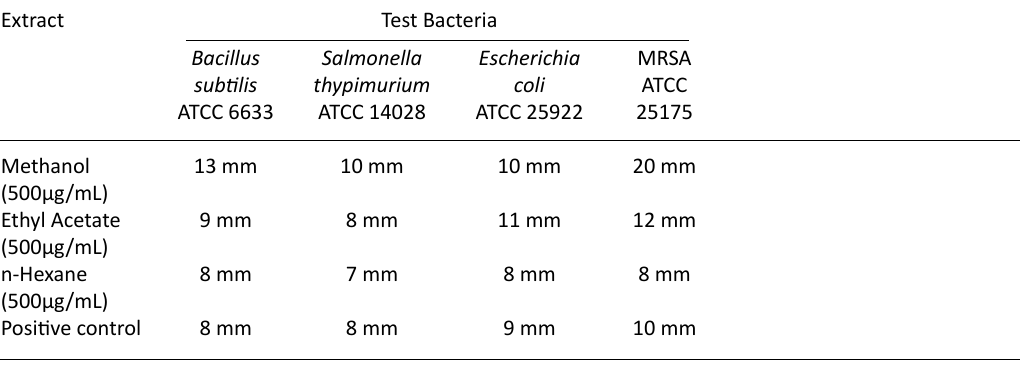
Table 4. Results of Measurement of Inhibition Zone Against 4 Test Bacteria Extract